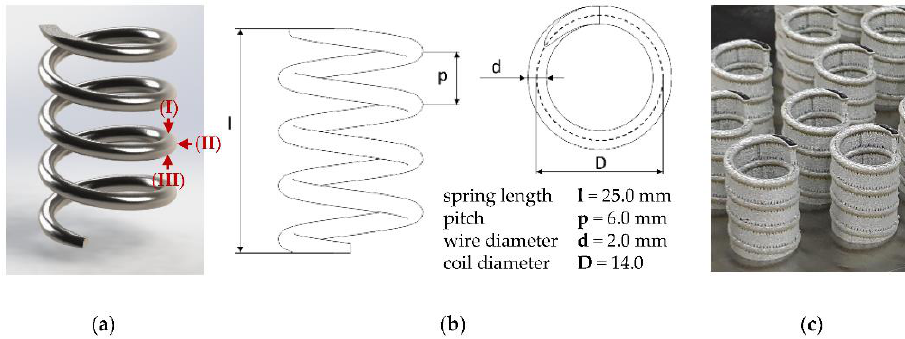
Figure 1. ( a ) CAD rendering of the chosen sample design, indicating the evaluated surface regions: (I) upskin surface, (II) lateral surface, (III) downskin surface, ( b ) spring design parameters, ( c ) as-built samples. Table 1. Chemical composition of the LBM powder and shape set wire as certified by the supplier in wt %, requirements according to ASTM F-2063. Element